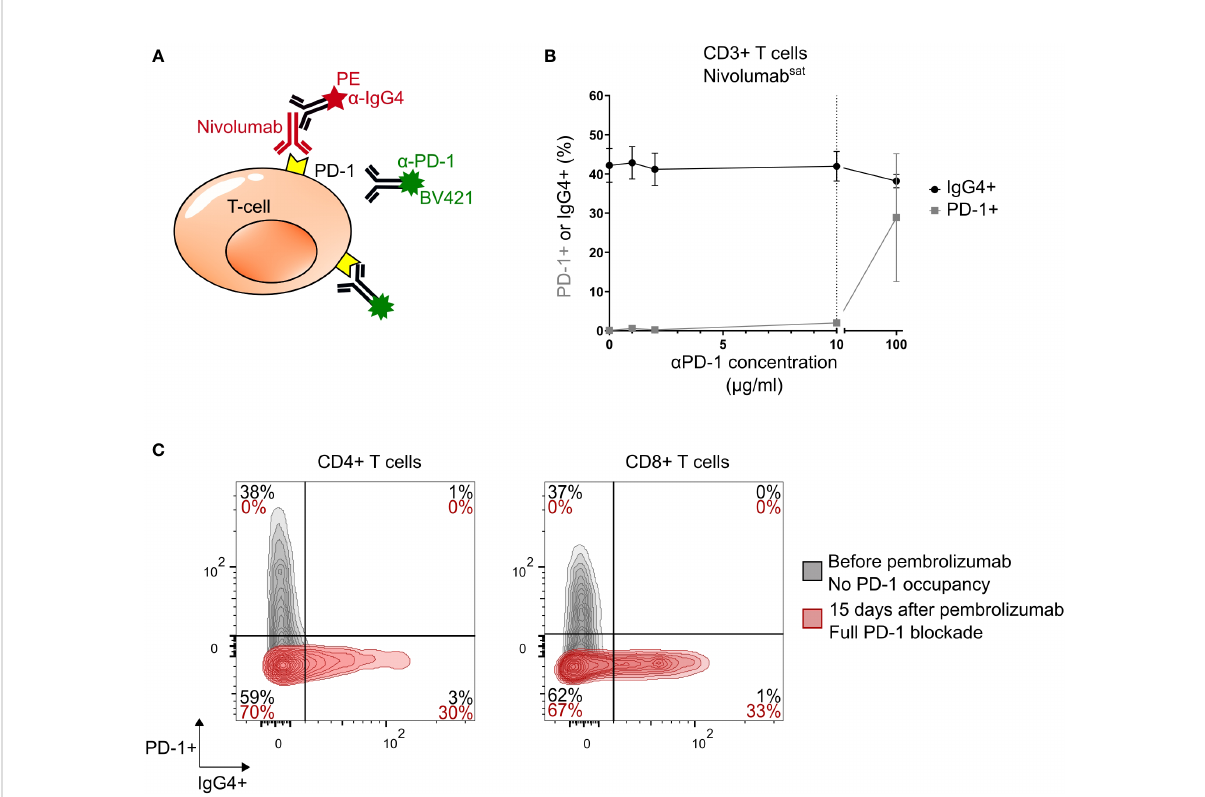
FIGURE 1 Competitive binding assay and phenotyping example. (A) Principle of the experiment. (B) Percentage of IgG4+ (black) and PD-1+ (grey) CD3+ T cells (mean ± SEM) after saturation (Nivolumab sat = a PD-1 sat = 1 mg/mL; 10 m L for 100 m L blood, 100 m g/mL fi nal) and adding increasing concentration of a PD-1 antibody on healthy donors ’ blood samples (n = 4). (C) Flow cytometry analysis of cells from blood of a patient (Pt#1) with PML (Progressive multifocal leukoencephalopathy) before (grey) and 15 days after pembrolizumab treatment initiation (red): IgG4, PD-1, and double staining PD-1+IgG4+ levels in CD4+ (left) and CD8+ (right) T cells. Population percentages. PD-1, Programmed cell death protein 1 receptor; SEM, standard error of the